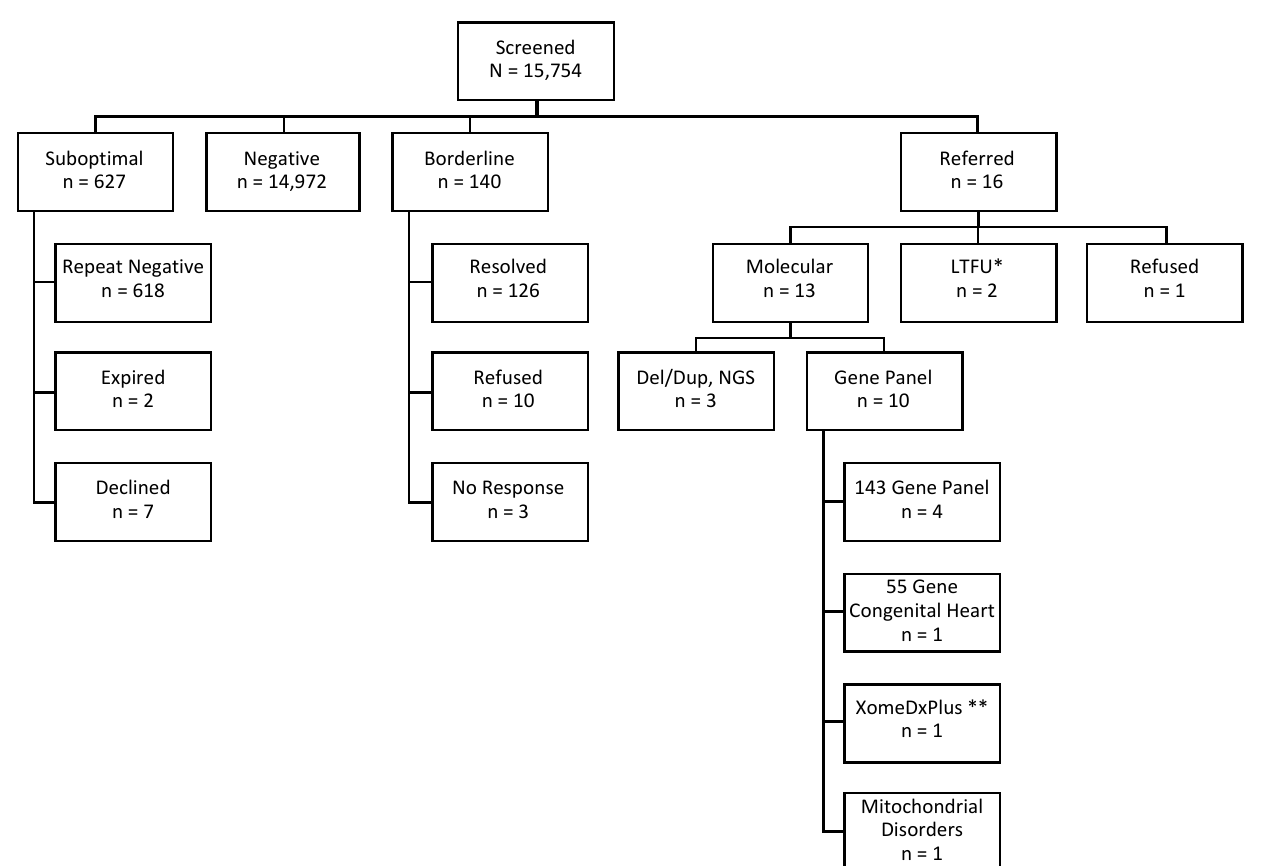
Figure 3. Overall screening results—* LTFU = lost to follow-up. ** XomeDxPlus is clinical exome sequencing with mitochondrial genome sequencing/deletion testing.